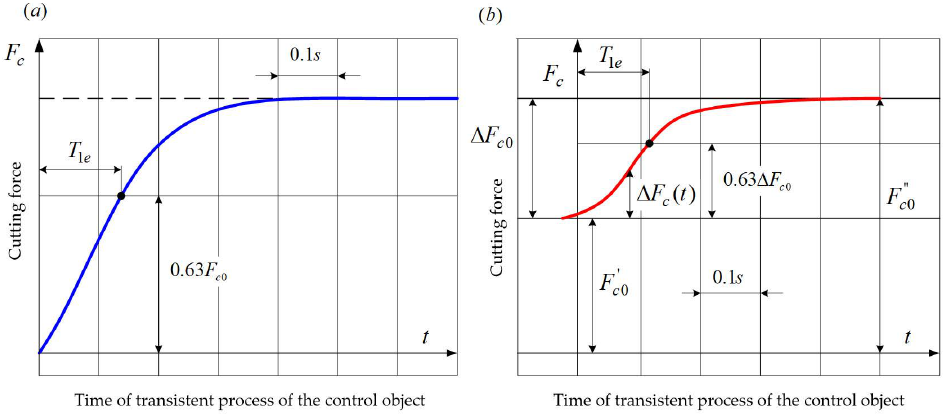
Figure 9. Experimental transient curves of the control object: ( a ) A transient curved obtained during the cutting process, ( b ) a second-order aperiodic link adopted as an approximate